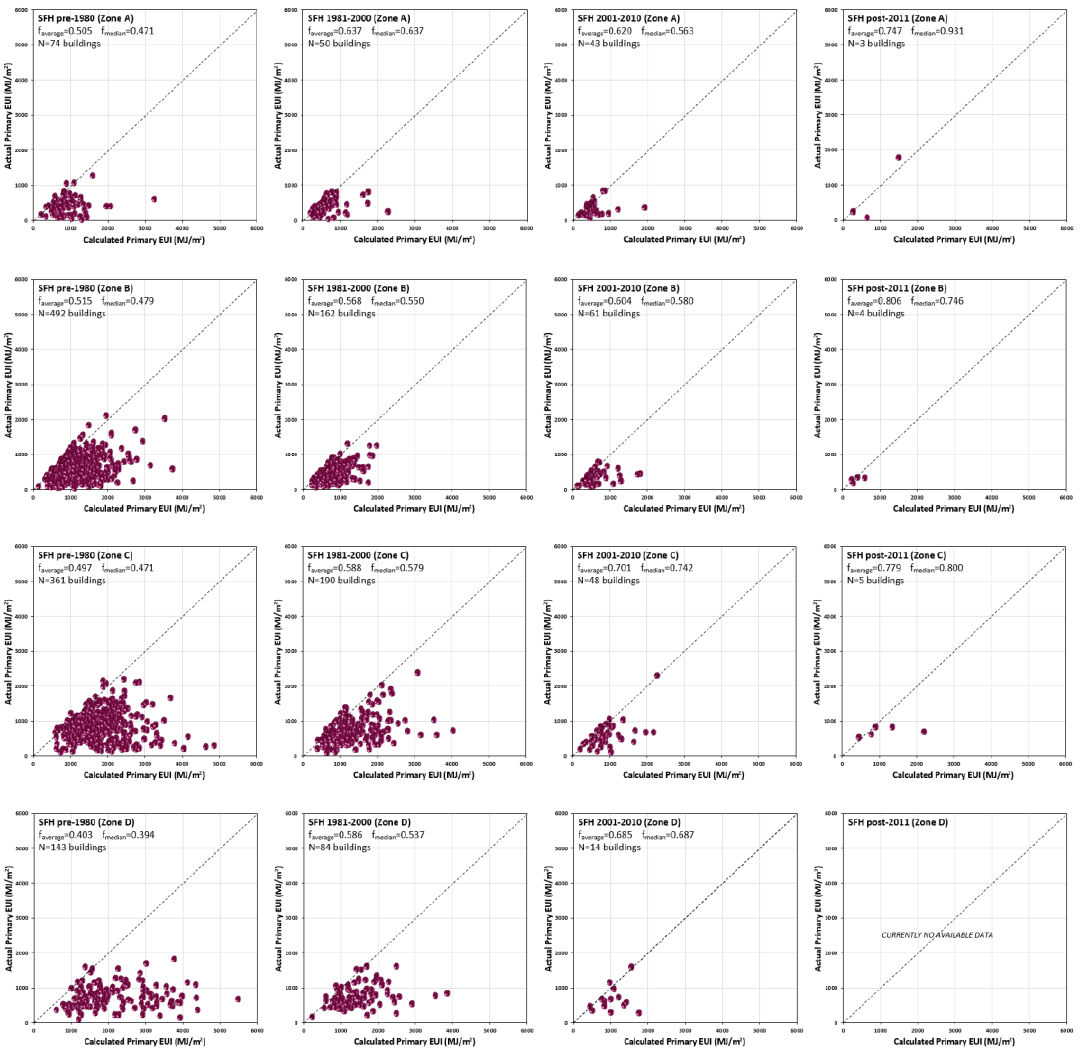
Figure A1. Calculated and actual space heating and DHW primary energy use intensity (MJ/m 2 ) from 1734 SFHs in Greece, grouped for the different tiers (four climate zones A – D and four construction periods).